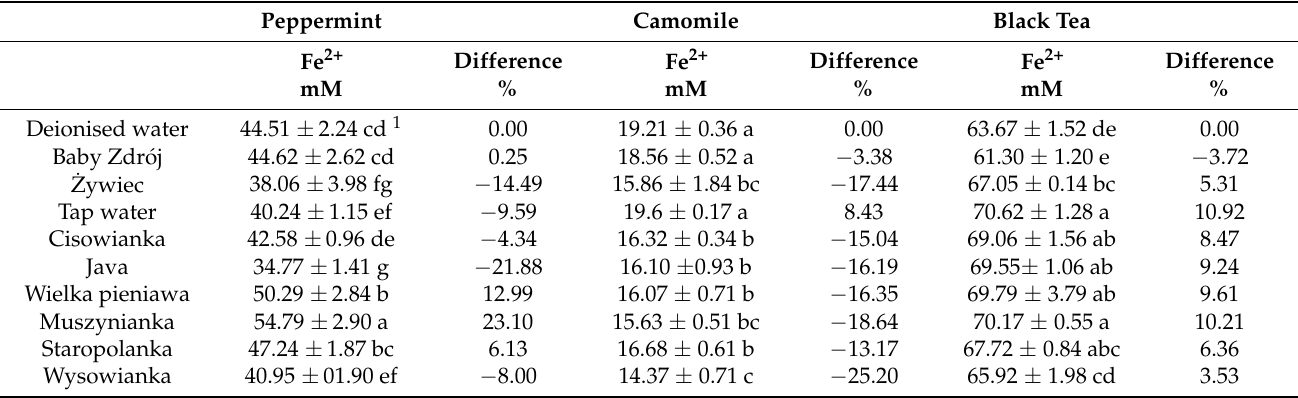
Table 4. Percentage decrease of Ferric Reducing Antioxidant Power (FRAP) (converted to mM Fe 2+) of peppermint, chamomile and black tea brews prepared with the use of mineral waters relative to the brew prepared with the use of deionized water.